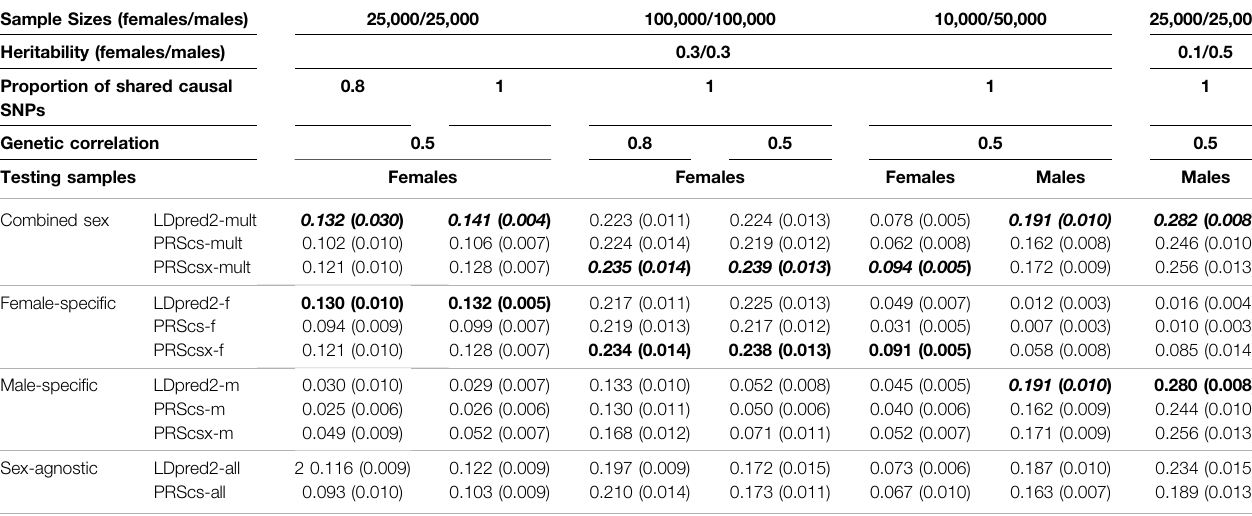
TABLE 1 | The median and standard deviation of R-squared for each method in different simulation settings. We only show the outcomes of simulated settings that bene fi t from sex-speci fi cPRSs.Becausethe prediction performances onfemales and males are consistent when sample sizes and heritabilityare both balanced across sexes, we only report the prediction accuracy on females in these cases. Bold and italics indicate the best results in each simulation setting, and the second-best results are presented only in bold . Sample Sizes